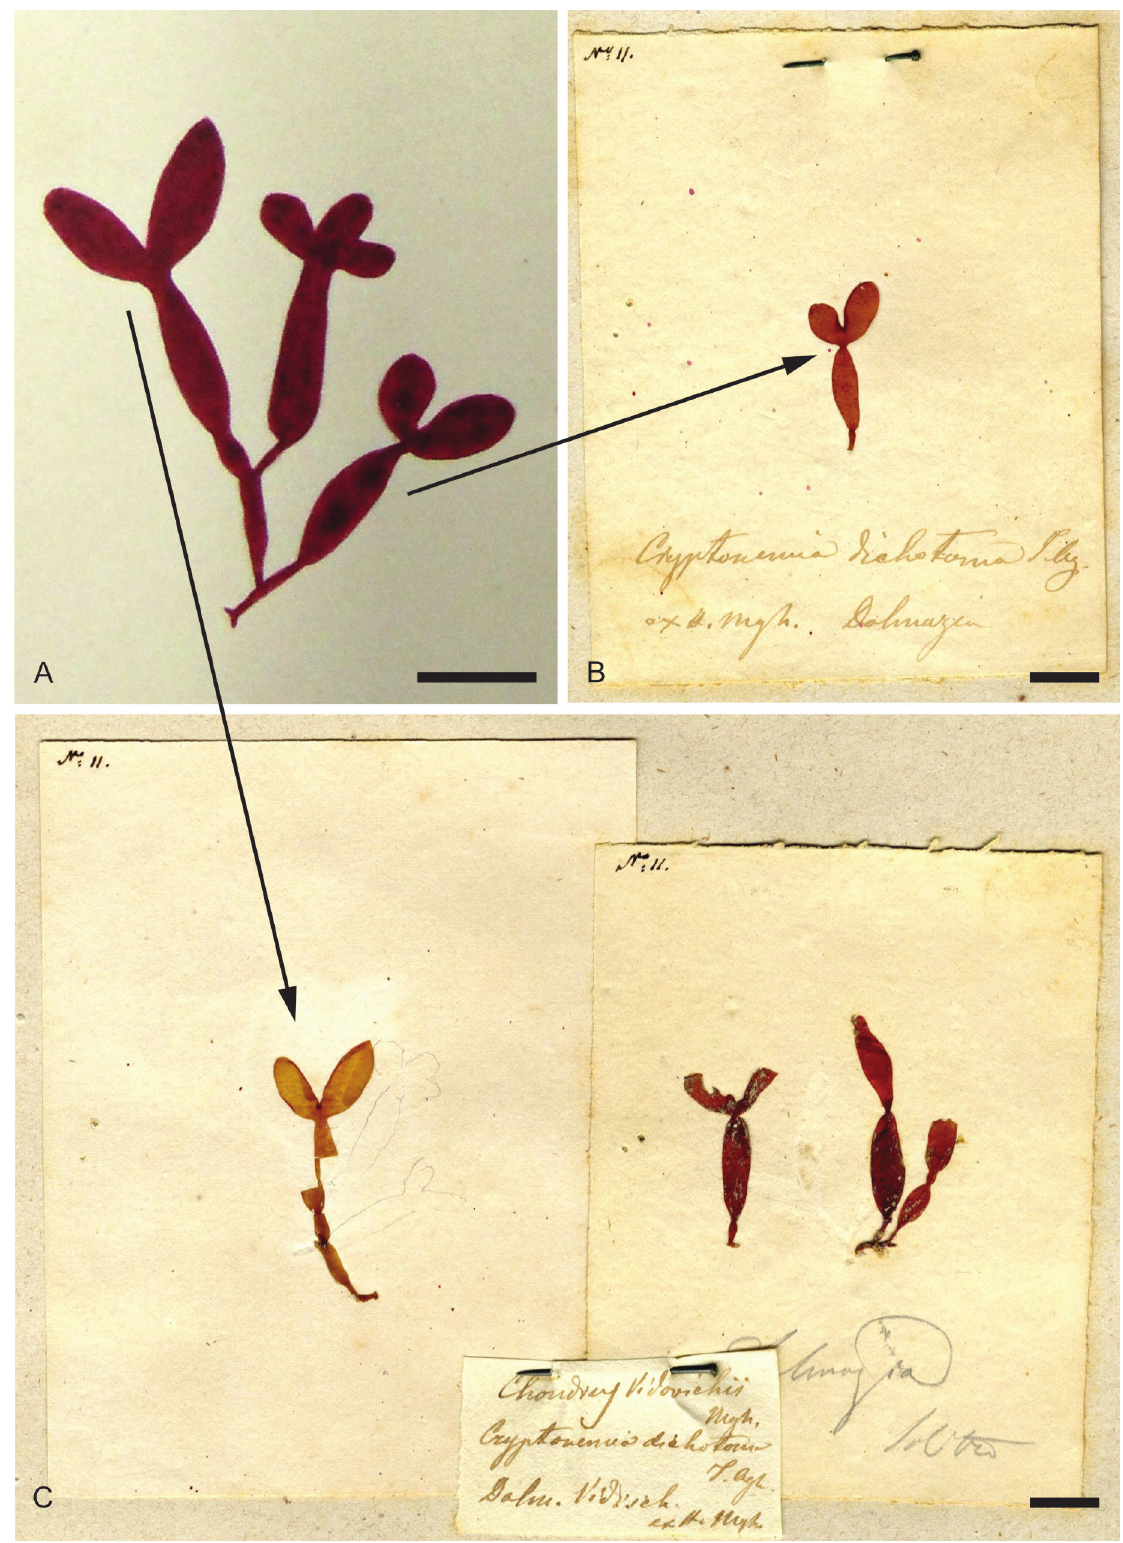
Fig. 7. Two fragments ( B – C , arrows) of the specimen ( A ) of Chondrus? vidovichii (Menegh.) Zanardini illustrated in Meneghini’s protologue manuscript. The sheets are currently filed in folder 742.4 , labelled “ Euhymenia dichotoma Kg .” at the Herbarium Orti Botanici Pisani (PI). Scale bars = 1